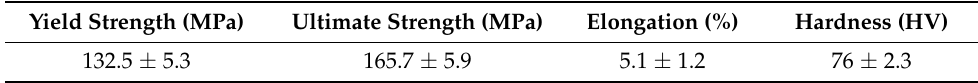
Figure 1. Optical microphotograph of Mg 97 Zn 1 Y 2 alloy. Table 1. Mechanical properties of Mg 97 Zn 1 Y 2